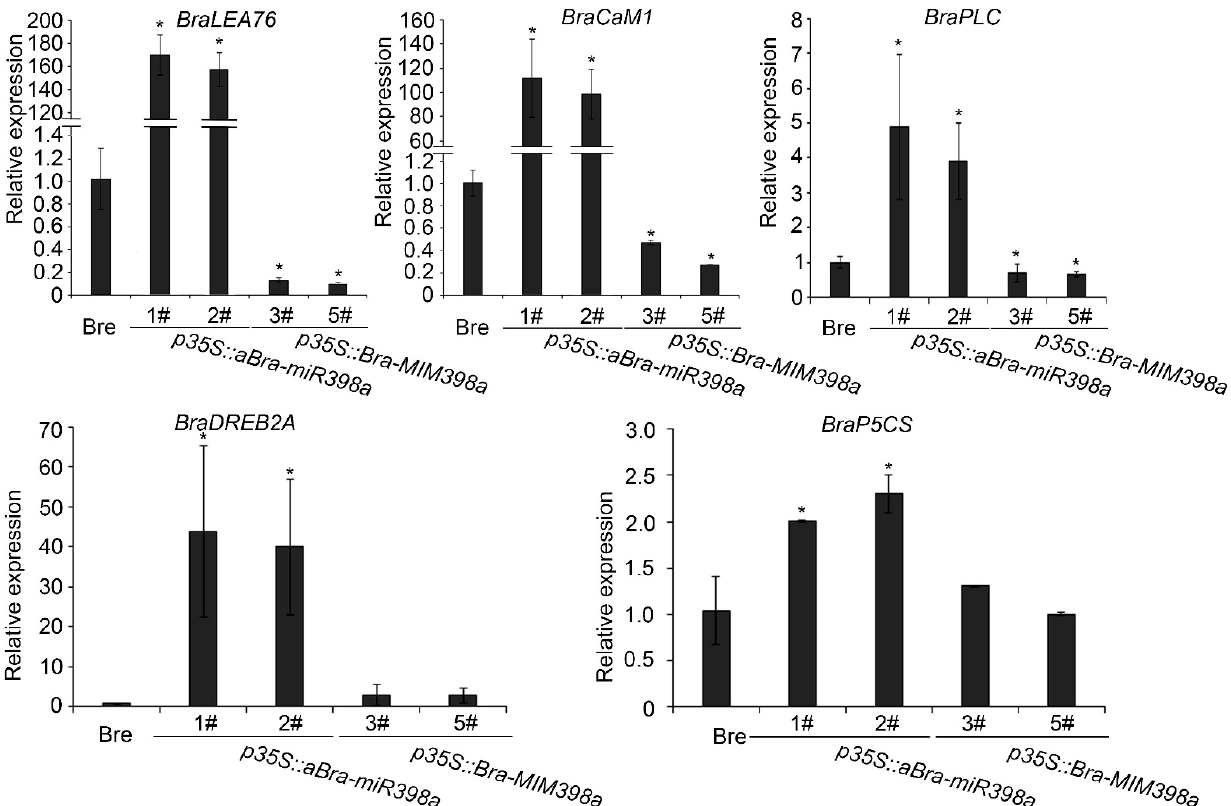
Figure 6. Expression level of cell death-related genes affected by miR398 and its targeted genes. Expression of BraLEA76 , BraCaM1 , BraPLC , BraDREB2A , and BraP5CS in Bre, p35S::aBra-miR398a (1#, 2#) and p35S::Bra-MIM398a (3#, 5#) plants at 38 °C for 1 h, respectively. The asterisks indicate a